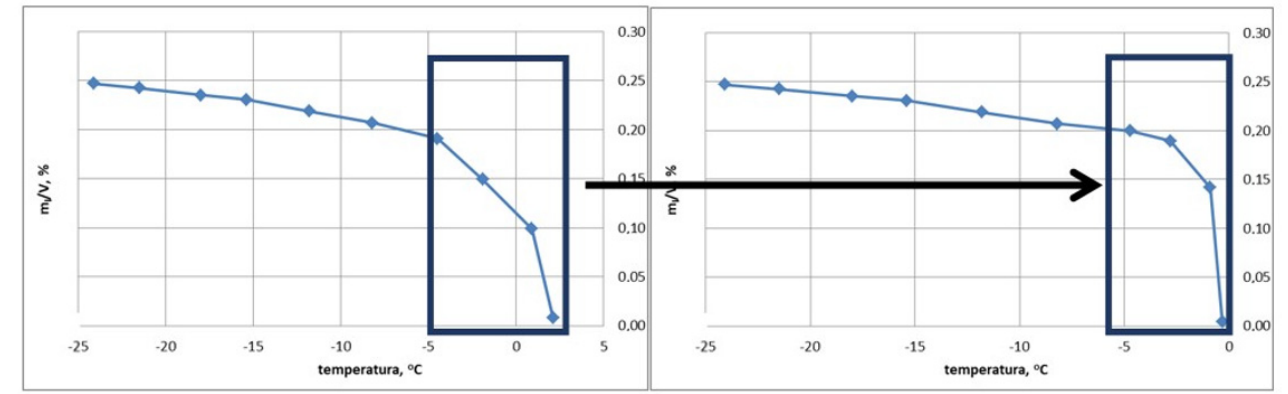
Figure 5. Example of changing the m L /V p plot in a sample during the heating process.